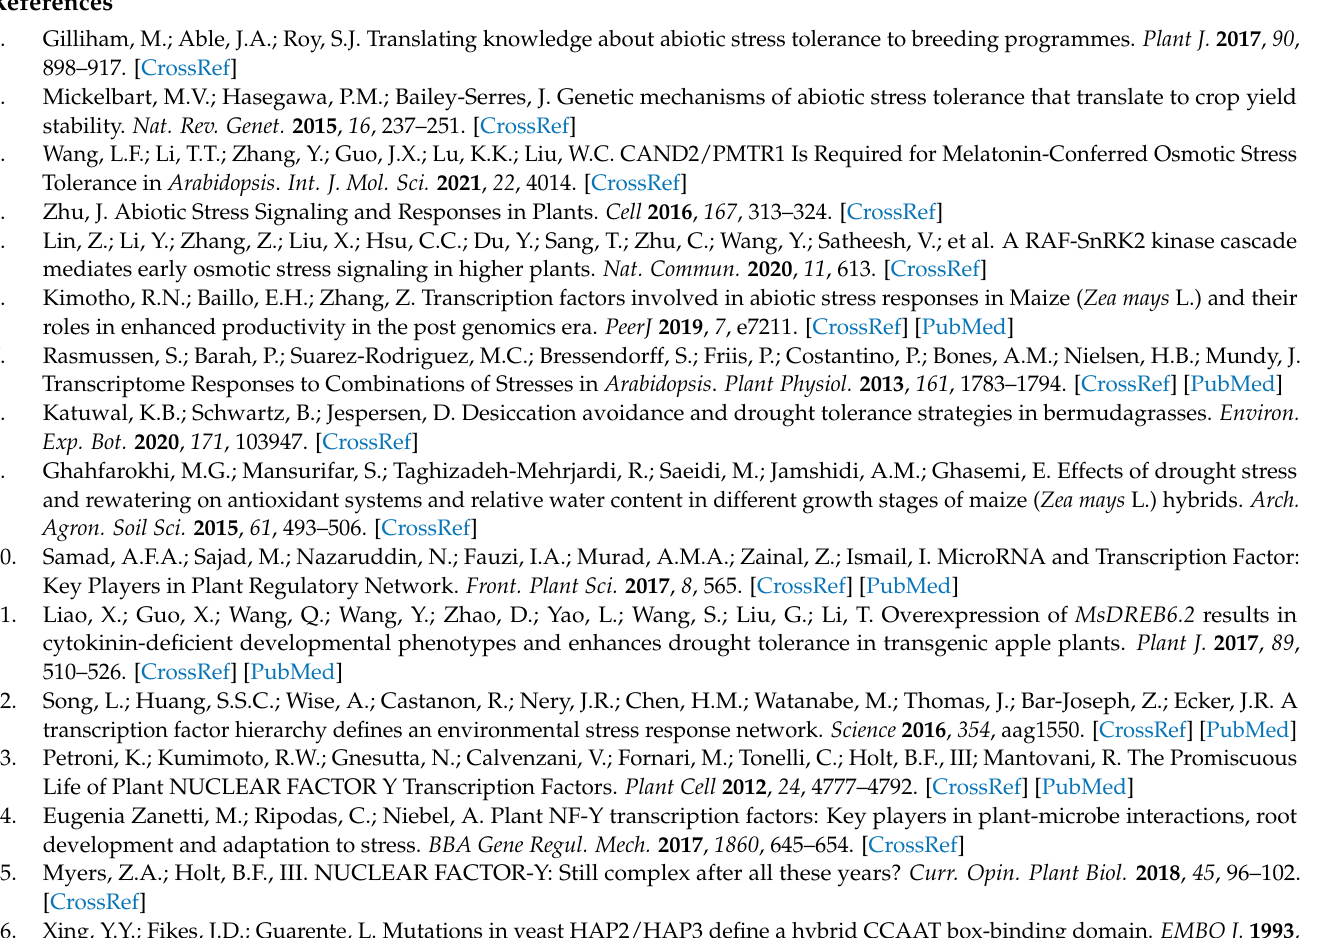
Table S4. Cis -element analysis of MdNF-Y promoter sequences, Table S5: Expression level of MsNF-Ys in different tissues and under drought treatment, Table S6: RT-qPCR primers, Table S7: Primers for constructing vectors, Table S8: Accession